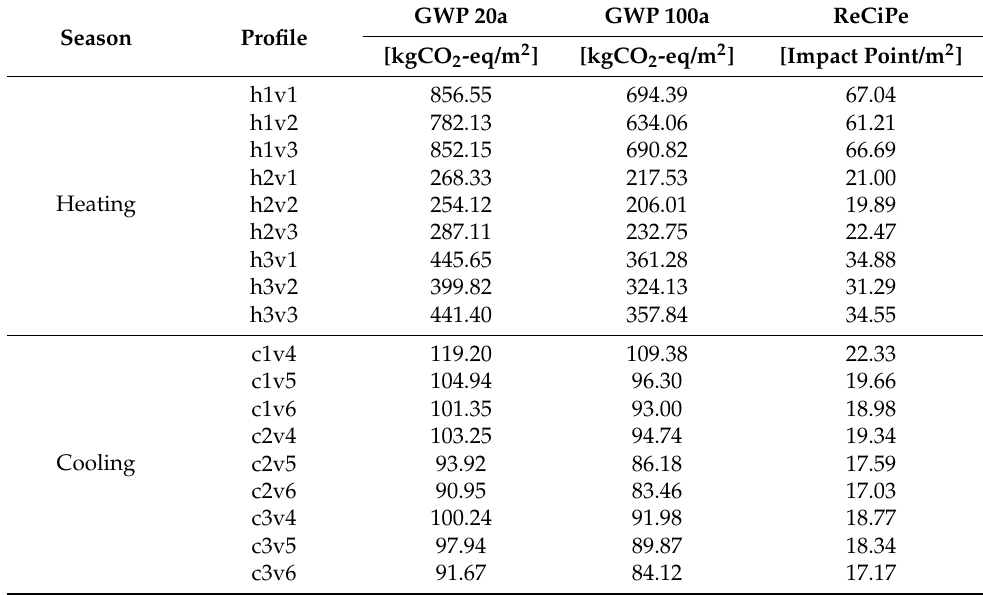
Table 10. Impact assessment during the operational stage for 90-year lifetime (LCA b ).